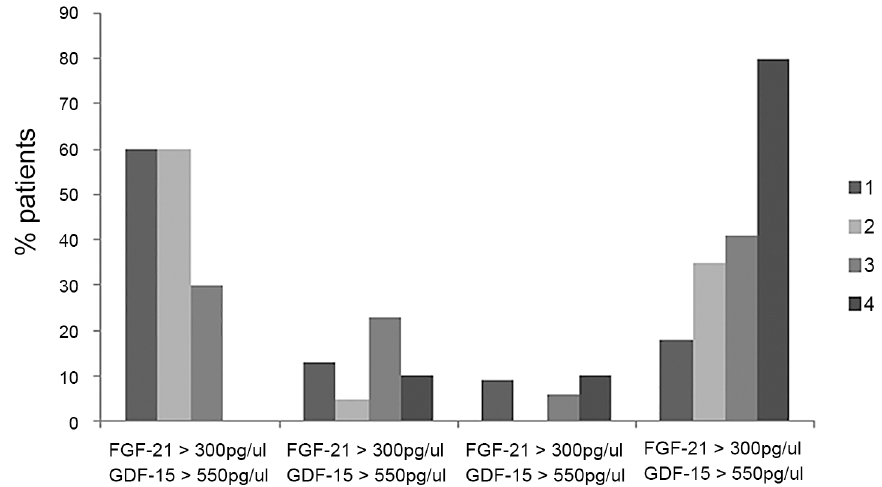
Fig 4. Histogram representing the percentage of patients in each group with both GDF-15 and FGF- 21above cut-off values, GDF-15 or FGF-21 elevated or both factors within normal values.